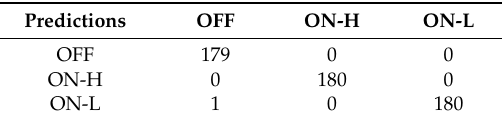
Table 6. Confusion matrix.